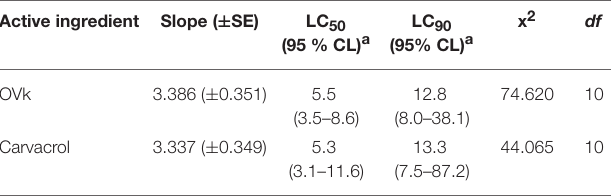
TABLE 6 | LC 50 and LC 90 values for Origanum vulgare ssp hirtum EO (OVk) and the its major component, carvacrol, against Macrocyclops albidus . Active ingredient Slope ( ± SE)